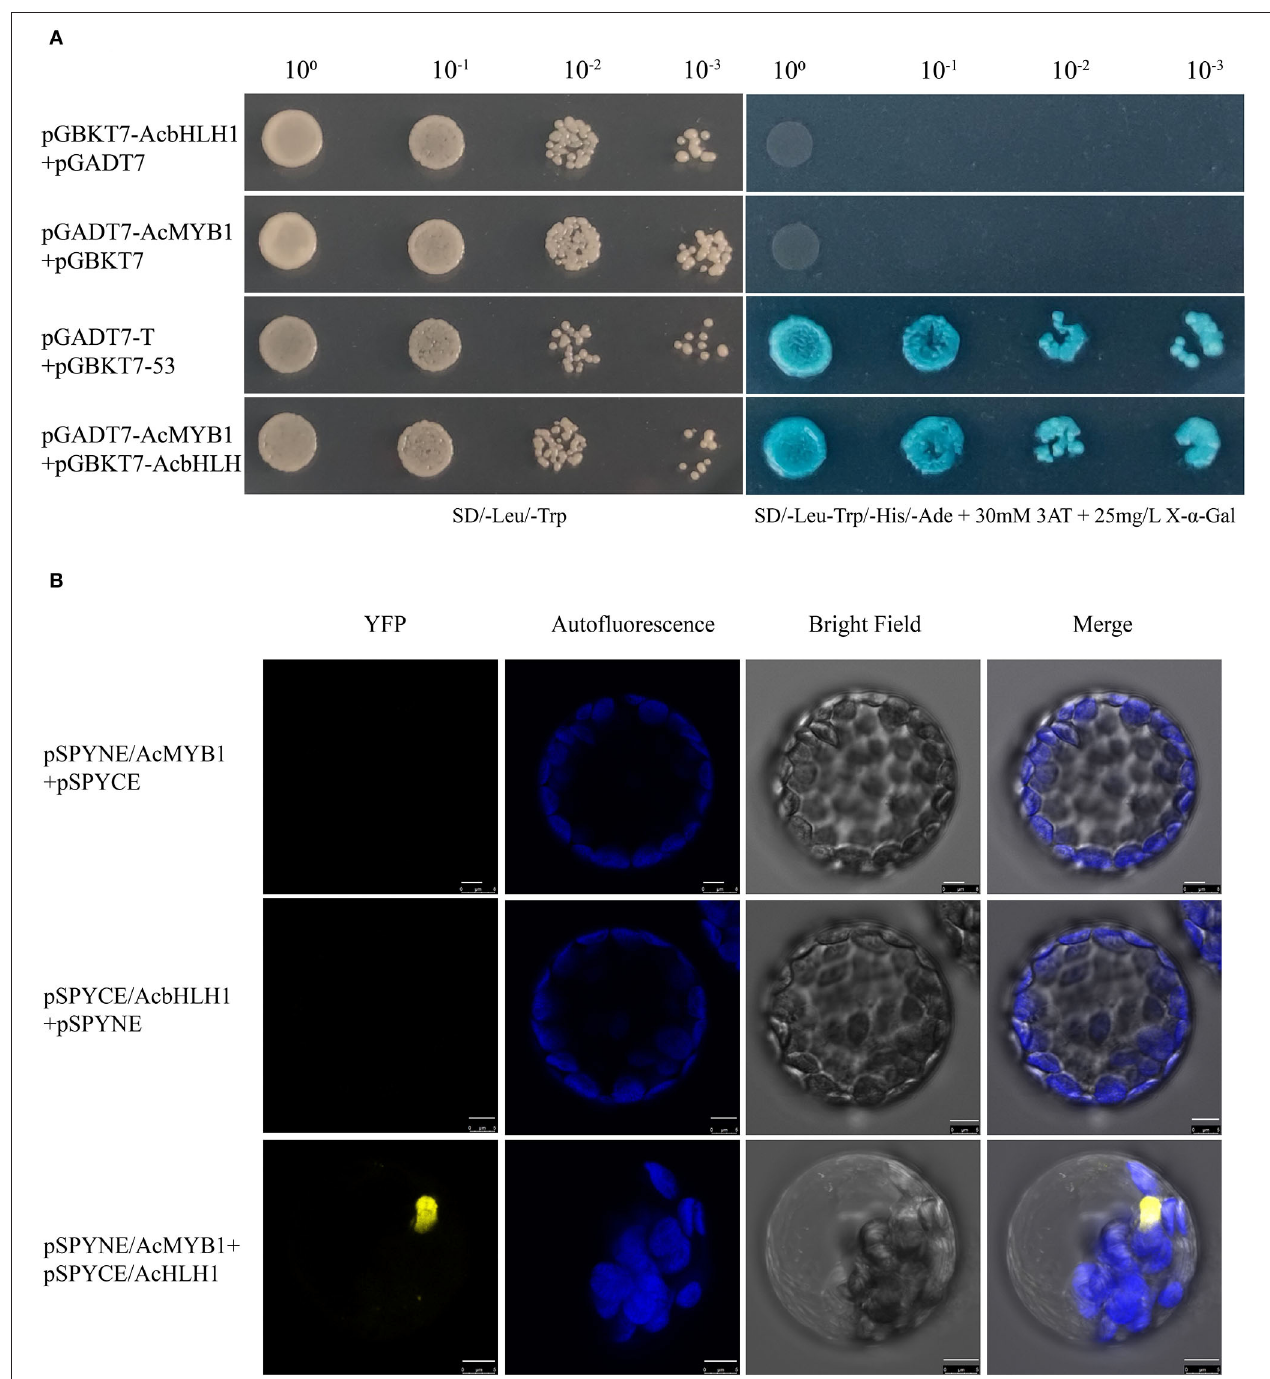
FIGURE 5 | Interactions between AcMYB1 and AcbHLH1 determined by Y2H and BiFC assays. (A) Y2H assay of AcMYB1 with AcbHLH1: co-transformed colony, pGADT7-AcMYB1 + pGBKT7-AcbHLH1; positive control, pGADT7-T + pGBKT7-53. (B) BiFC assay showing the fluorescence signal of co-expressed pSPYNE/AcMYB1 + pSPYCE/AcbHLH1 in Arabidopsis thaliana leaf protoplasts. Representative images under the YFP fluorescence, chlorophyll autofluorescence, bright field, and merged images. Scale bar: 5 µ m. in light treatment seedlings is 11.2-fold higher than that of the dark or light for 5 days. As shown in Figure 9A , the the seedlings growing in dark ( Figure 9B ). Furthermore, the leaf color was bright red in light treatment plants and pale transcriptional level of AcMYB1, AcbHLH1, and 10 pink in dark-grown plants. The leaf anthocyanin content